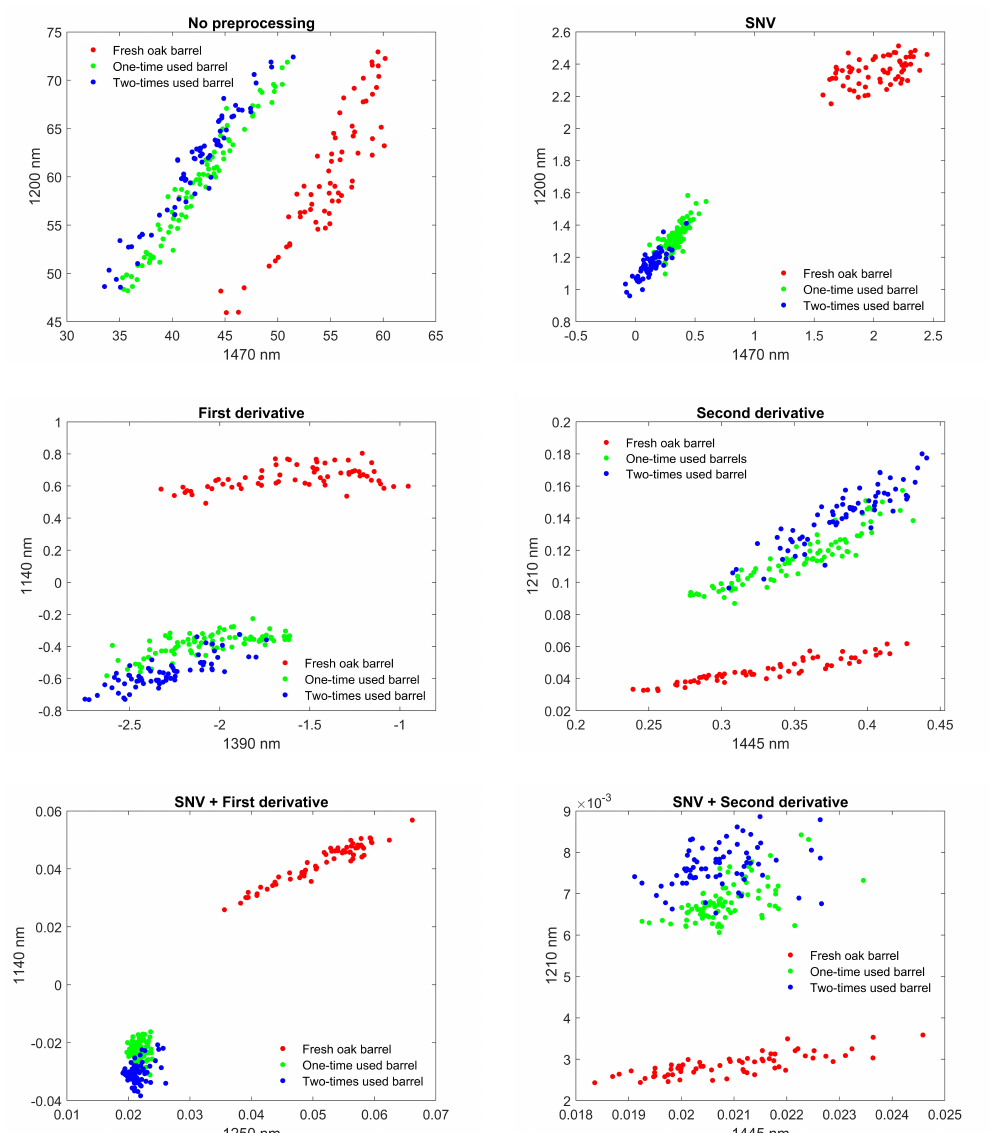
Figure 4. Scatter plot of the different measurement points on fresh, one–, and two–times wine refills marked with red, green, and blue dots, respectively. The scatter plot is extracted by reducing the reflectance spectra to a discrete set of two wavelengths. The wavelengths chosen correspond to characteristic absorption bands or maximum/minimum slopes in the derivative spectra. Clustering based on filling in 2 dimensions is improved by applying pre-processing techniques. SVN even has decent clustering in 1 dimension (1200 nm or 1470 nm) by projecting on either